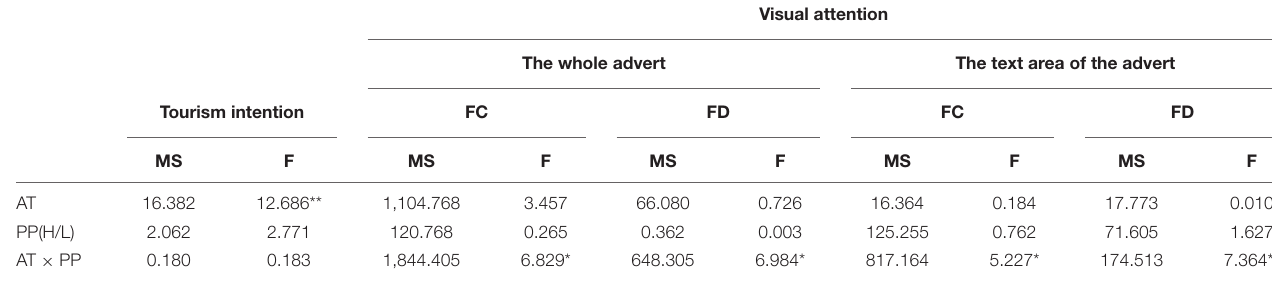
TABLE 2 | Results of repeated measures of two-factor ANOVA.